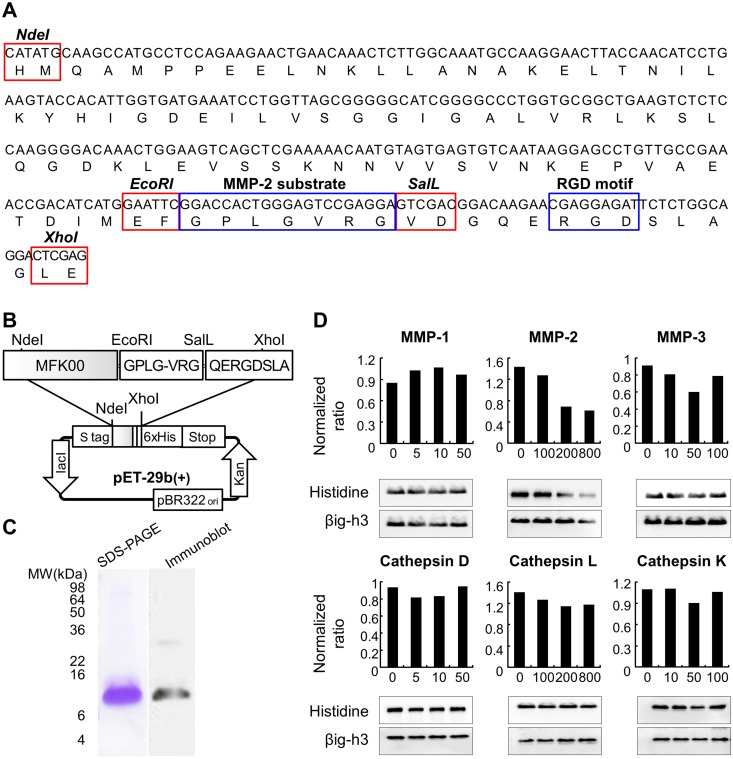
Identification of matrix metalloproteinase-2 (MMP-2)-specific cleavage of MMP-2-cleavable peptide complex, MFK902.(A) Sequence of recombinant murine MFK902 consisting of MFK00 (murine 4th fas-1 peptide truncated for the H1 and H2 sequences) and an RGD motif linked by a MMP-2 substrate (GPLGVRG). (B) Schematic representation of the pET-29b(+) vector containing the MFK902 sequence. (C) Immunoblot of purified recombinant MFK902. (D) MMP-2–specific cleavage of MFK902 was performed as detailed in the Methods section.